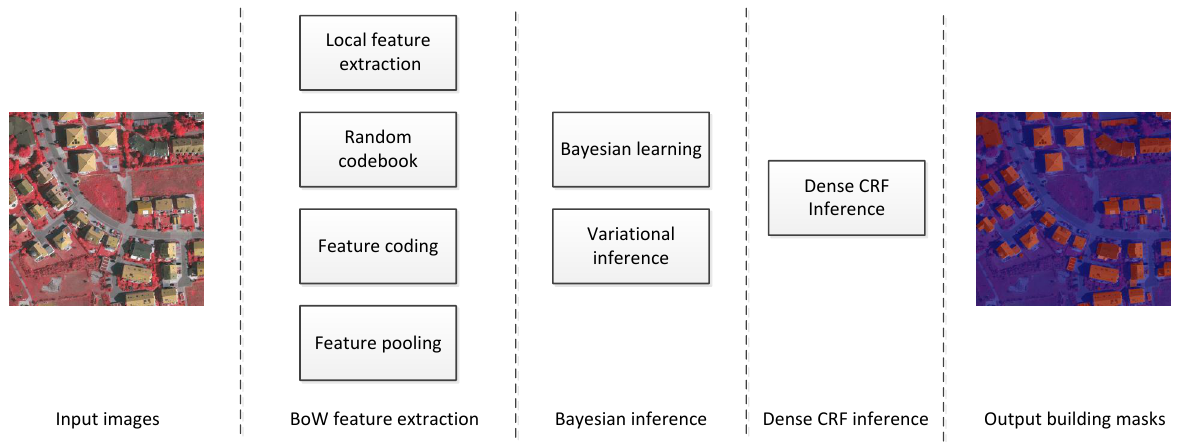
Figure 1. The workflow of the proposed method for building detection. It consists of three steps: BoW feature extraction, Bayesian learning, and Dense CRF for building pixel labeling.